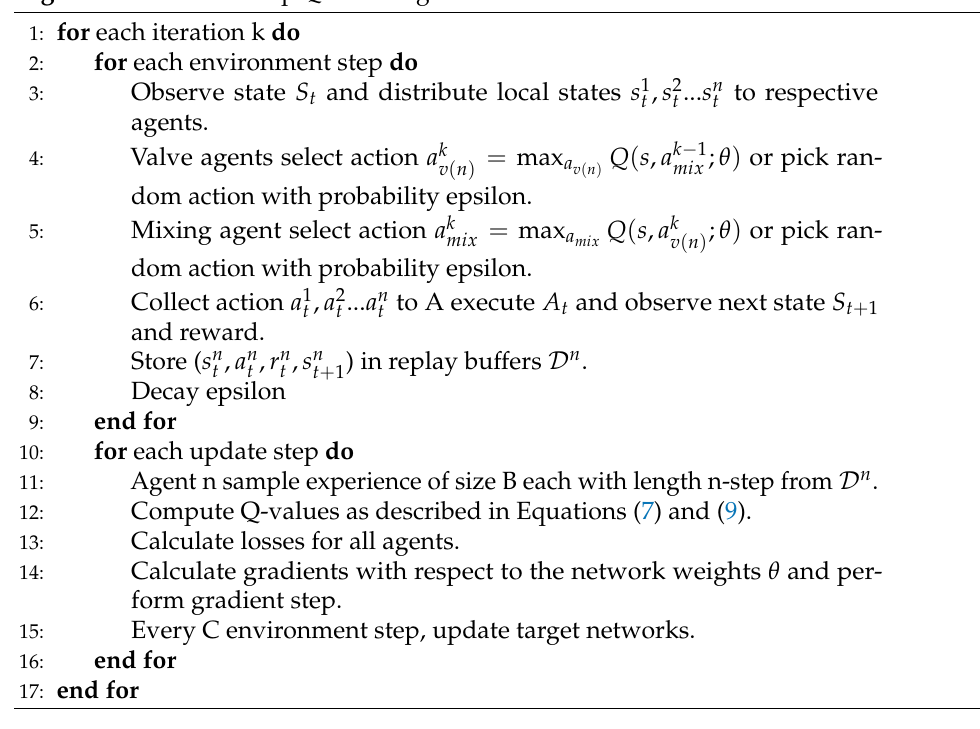
Algorithm 1 MARL Deep